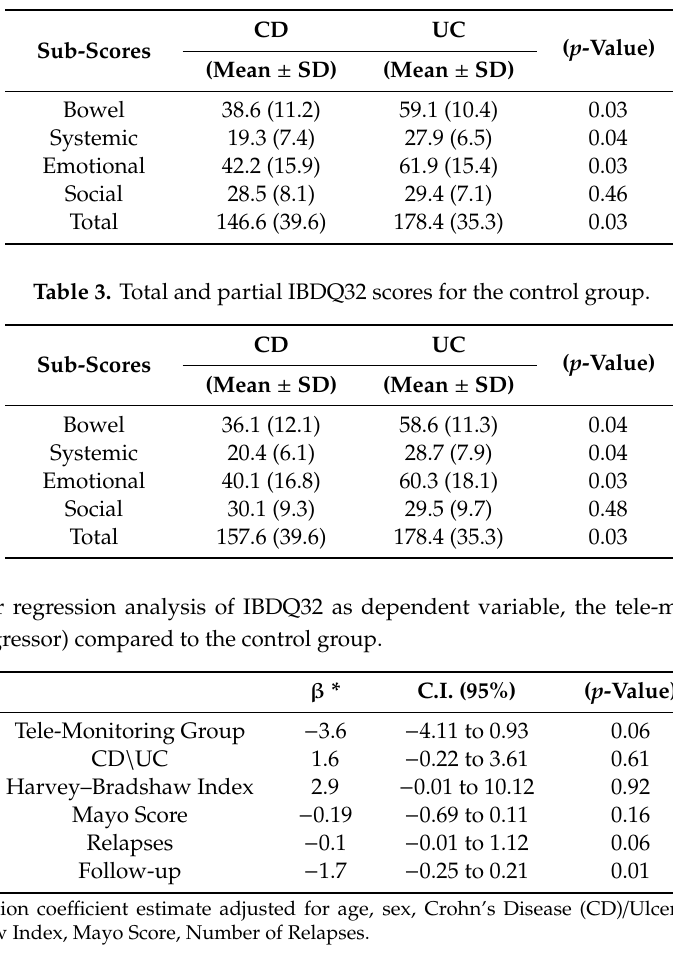
Table 2. Total and partial IBDQ32 scores for the tele-monitoring group.